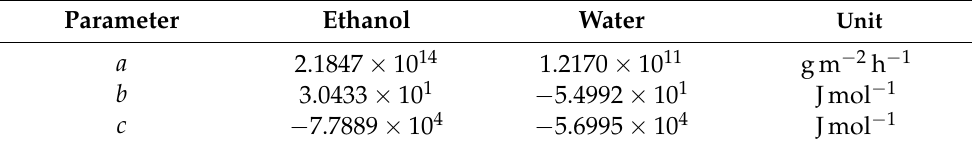
Table 3. Calculated model